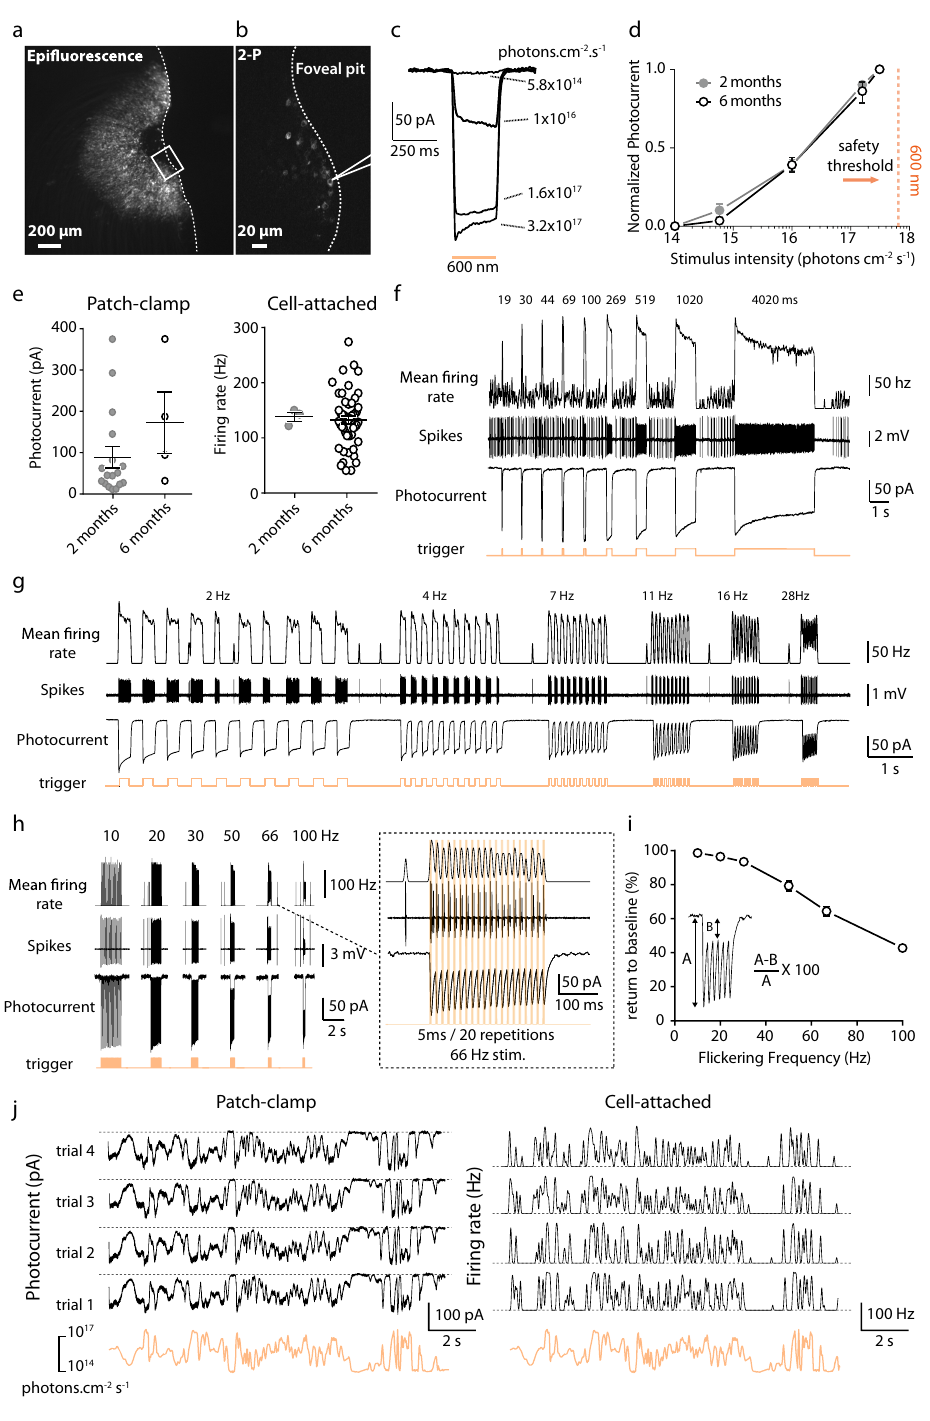
fi eld angle of 0.375° moving at 11 or 22 °/s. For calculation of the visual fl ow elicited, we used spike sorting on the recorded activity, followed by plane fi tting to the peak of the cell responses, to esti- mate the direction of the bar (Fig. 6a and Supplementary Fig. S7) and its speed (Fig. 6d). The plane fi tting method made it possible to identify, for each direction, the unique succession of cells activated along the path of the bar (Fig. 6a – c). This temporal response of the cells was found to be suf fi cient for correct estimation of the direction and velocity of the bar over the retina, despite the discrete spacing of